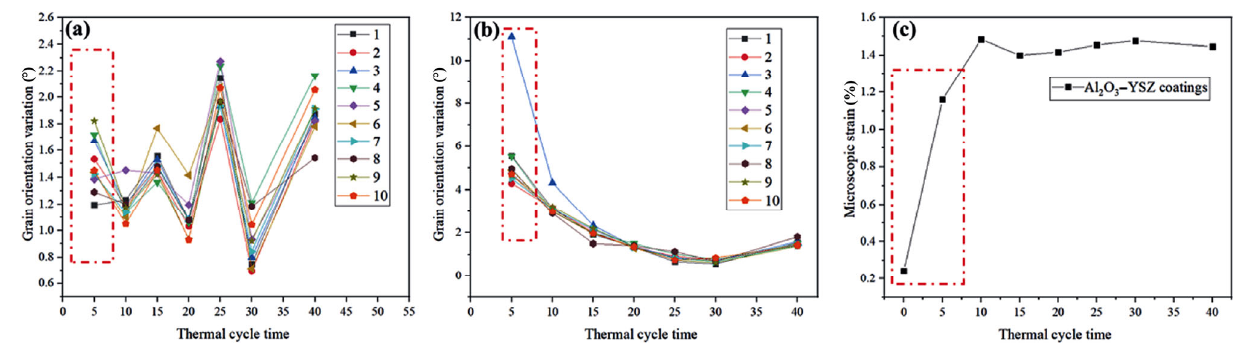
Fig. 5 Grain orientation variation trend of (a) YSZ coating and (b) Al 2 O 3 –YSZ coating during thermal cycles; (c) microscopic strain of Al 2 O 3 –YSZ coating during thermal cycles.